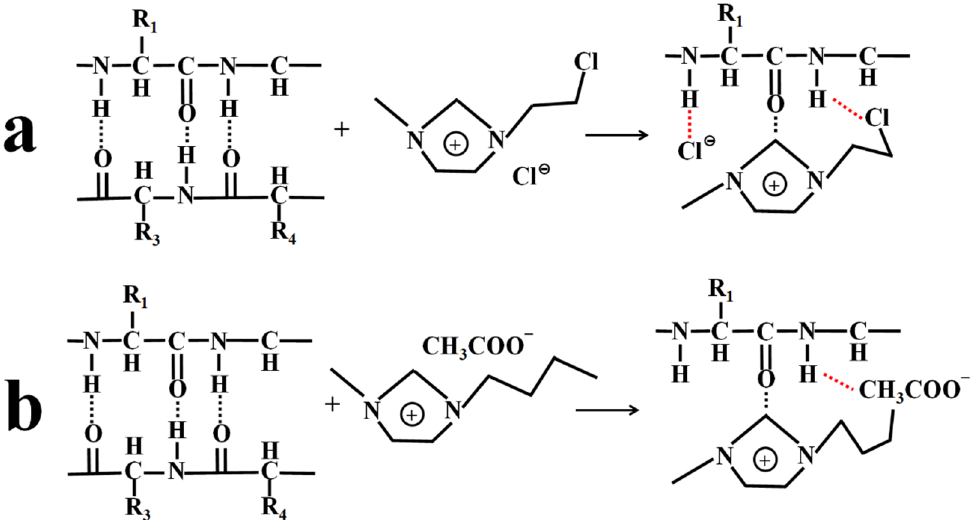
Figure 5. The mechanism of ILs dissolving SF. The − NH of protein chains interact with ( a ) Cl − of [CeMIM]Cl and ( b ) CH 3 COO − of [BMIM]AC to form new hydrogen bonds, which promote the dissolution of SF.